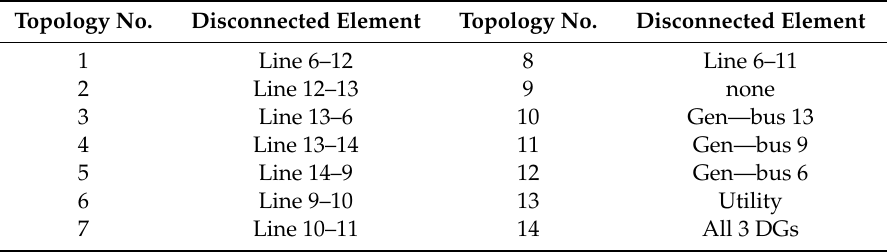
Table 6. System topologies